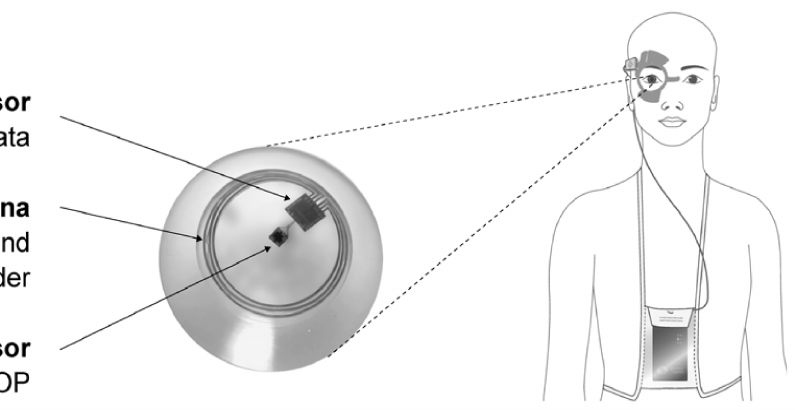
Figure 1. Subunits of a contact lens for measuring IOP. Reprinted with permission from Wasilewicz et